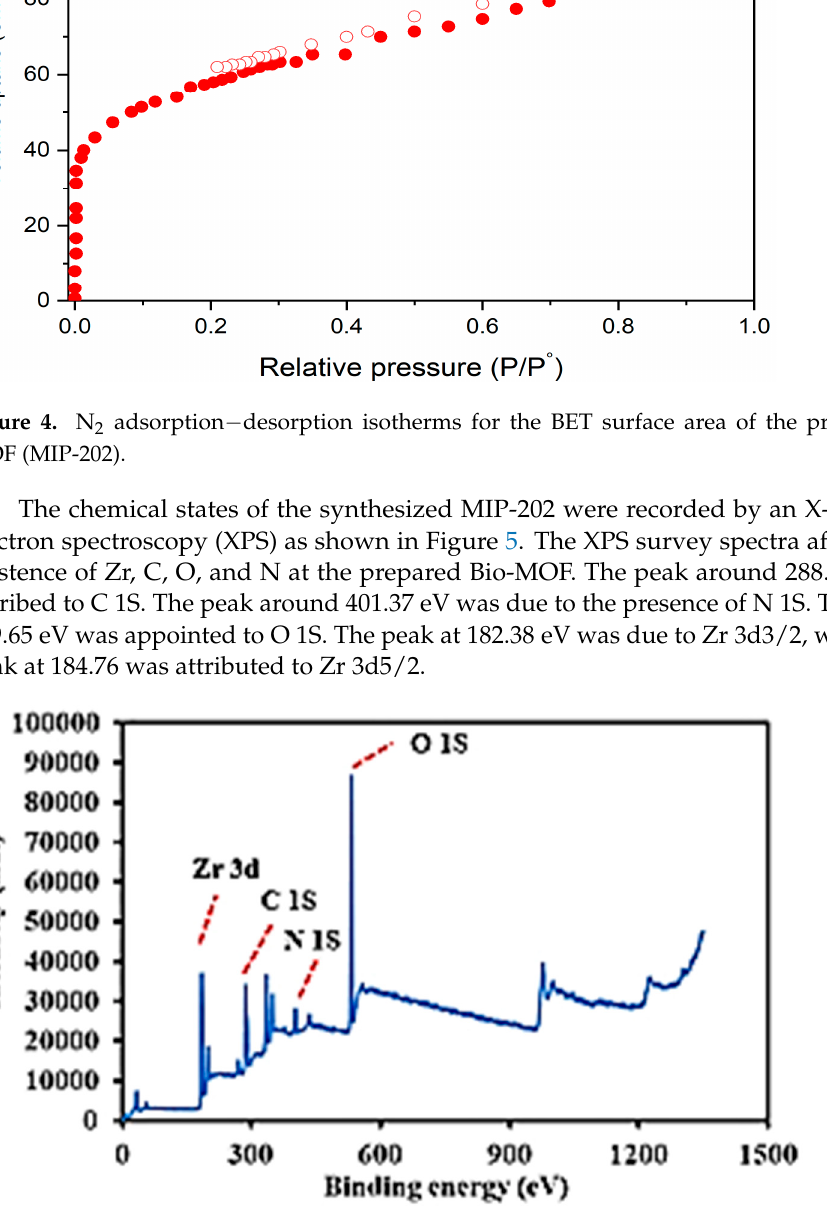
Figure 5. XPS analysis of the prepared Bio-MOF (MIP-202).